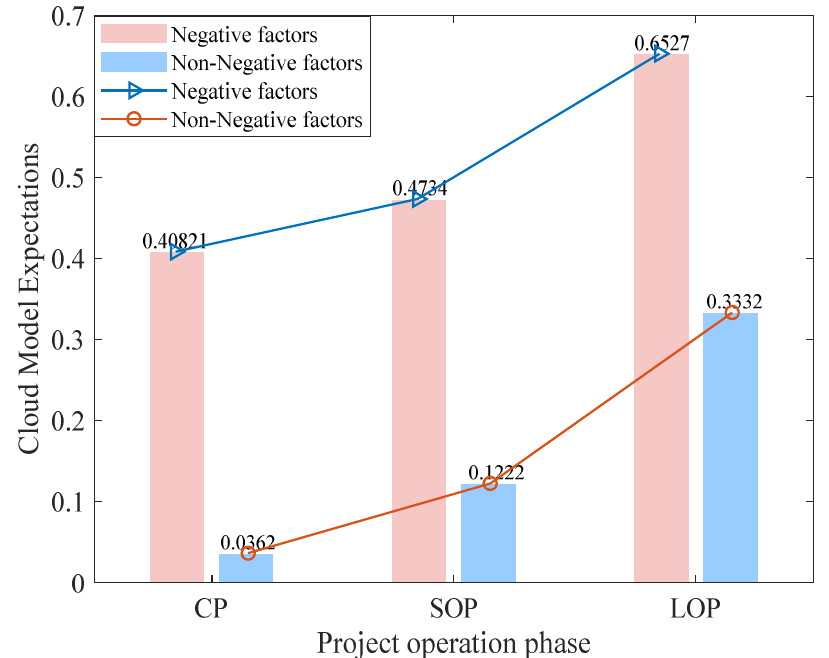
Figure 8. Comprehensive assessment results of environmental impact in three phases of the ERP.